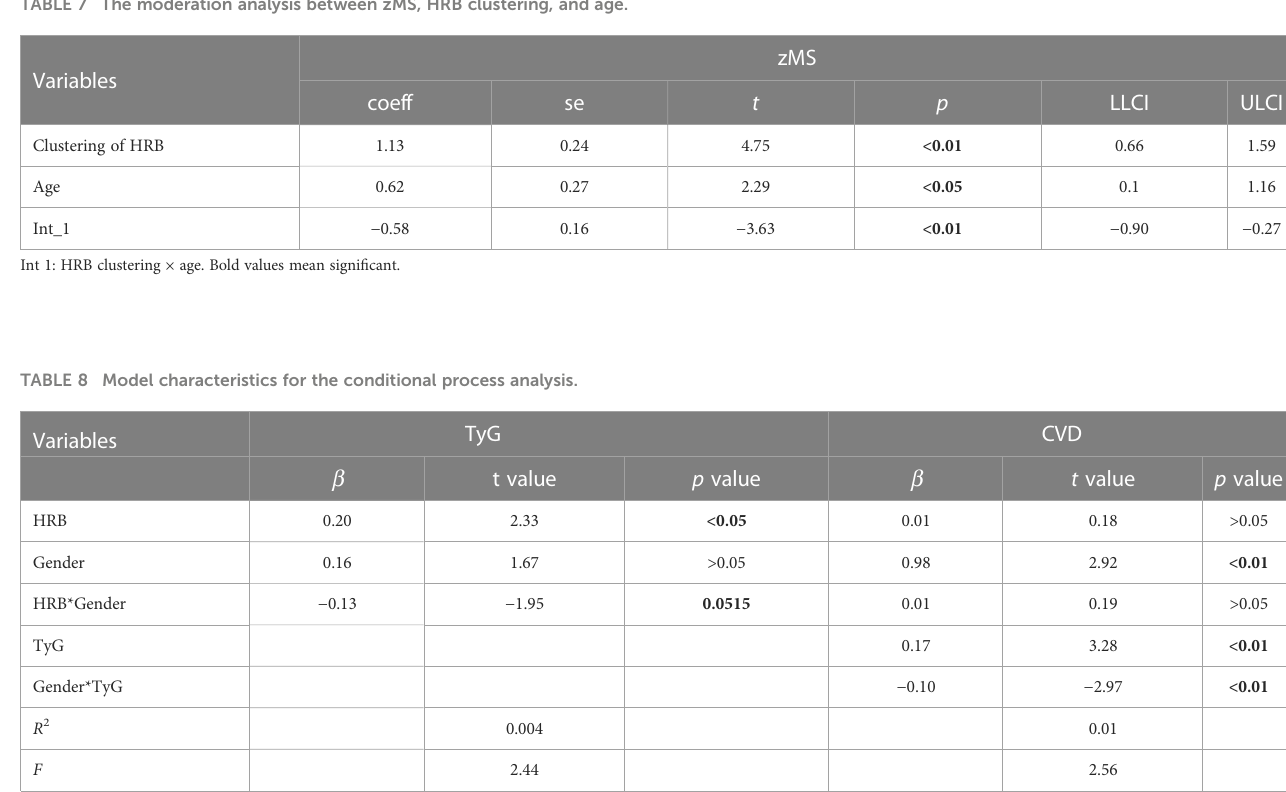
TABLE 7 The moderation analysis between zMS, HRB clustering, and age.